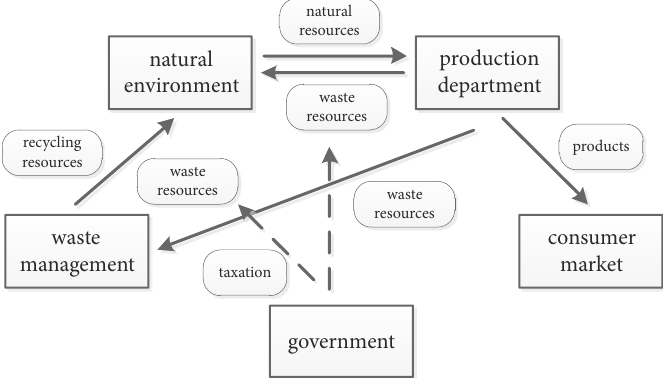
Figure 6. Pollution tax model without recycling resource